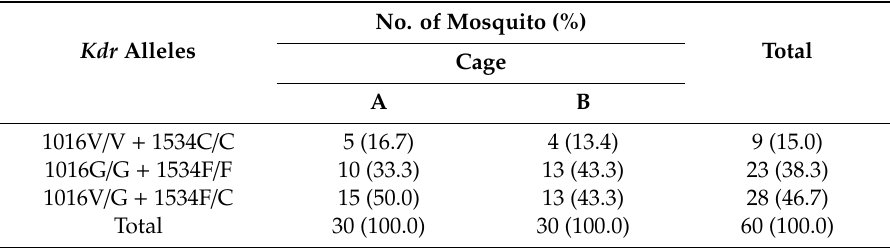
Table 4. Frequencies of V1016G and F1534C alleles in F 1 adult progeny reared from eggs obtained from cages containing equal pairs of males and females of PMD-R and UPK-R